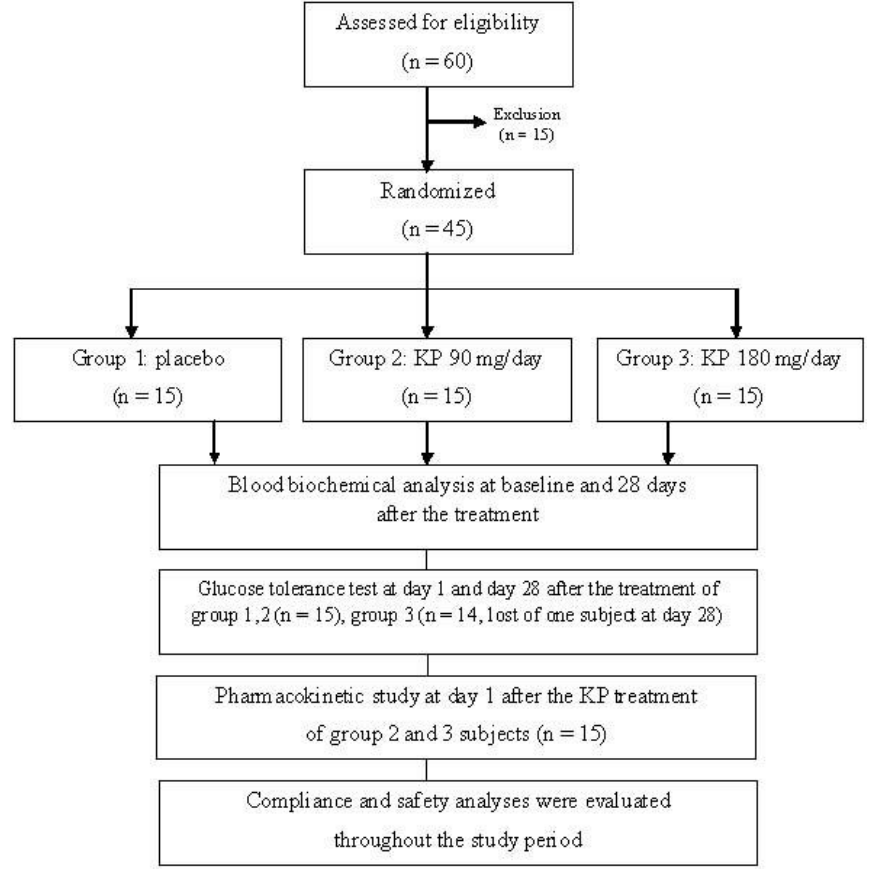
Figure 2. Flowchart illustrating the phases of the study. KP : Kaempferia parviflora .